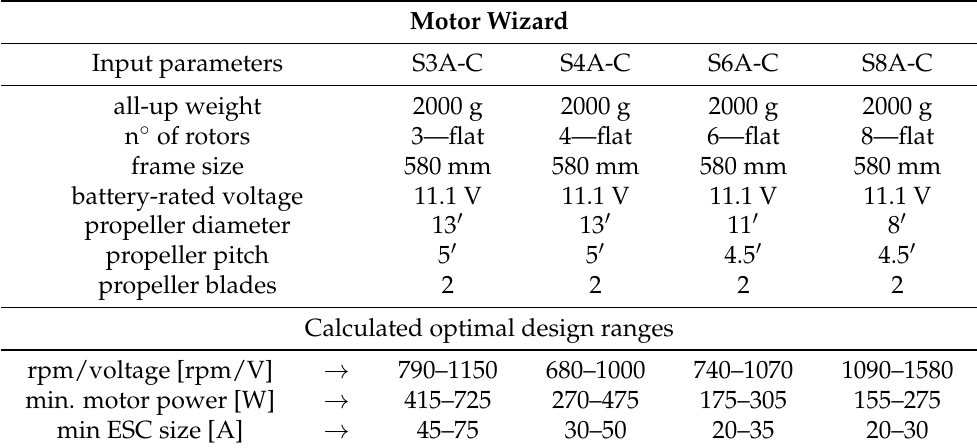
Table 2. Design of a modular drone: optimal motor design ranges per each configuration.